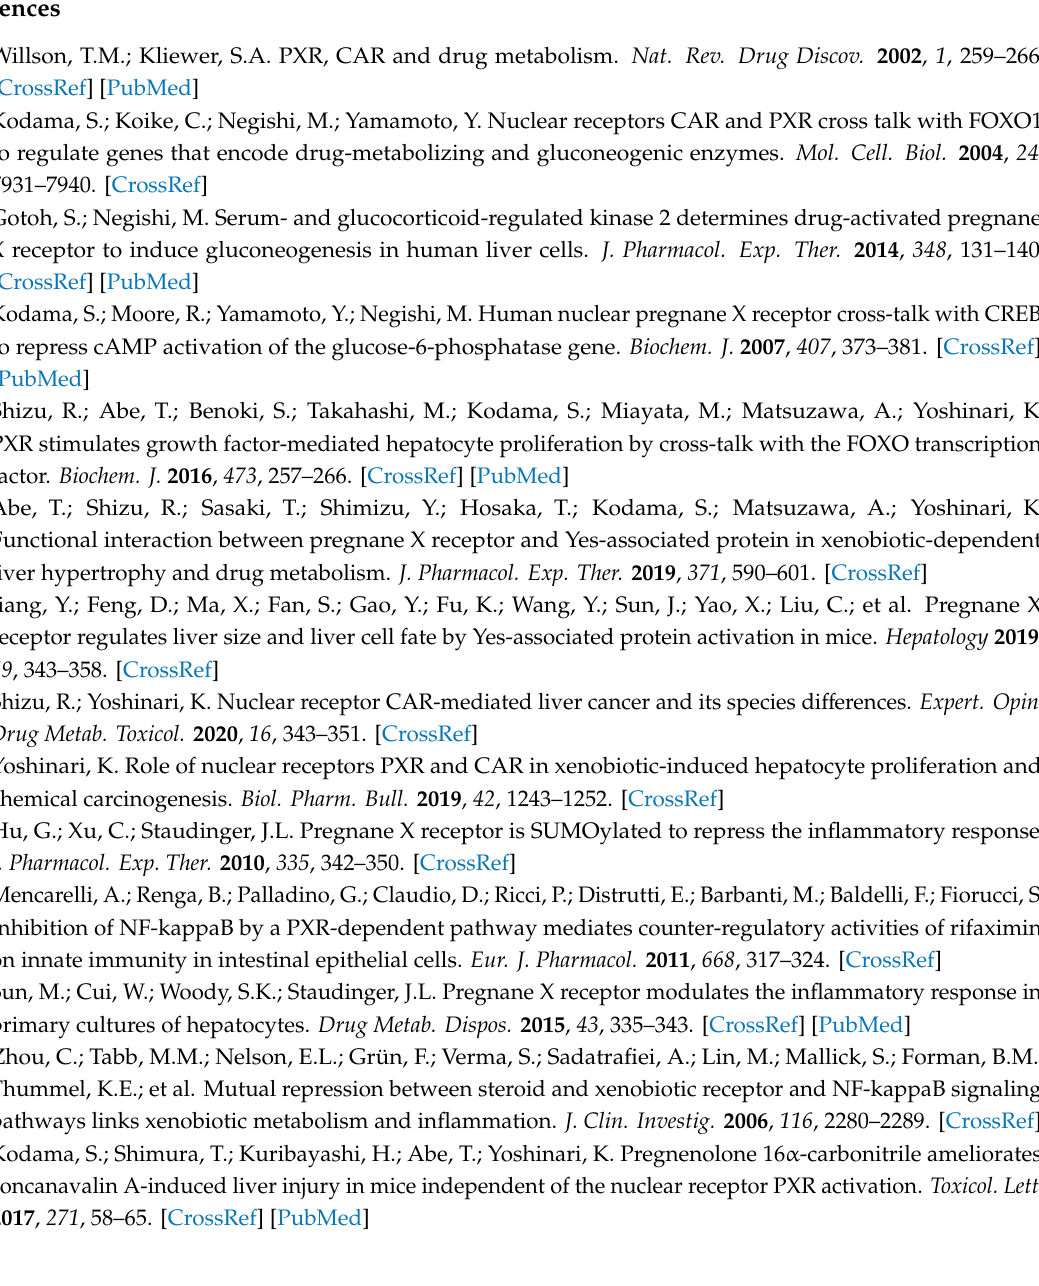
Figure S1: E ff ect of amprenavir treatment on CCl 4 -dependent induction of the hepatic mRNA levels of Ccl2 and Cxcl2 in mice. Table S1: Primers used for